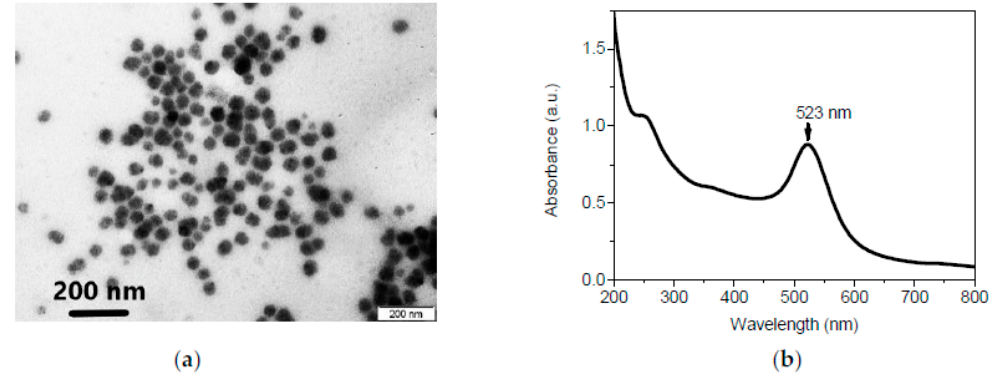
Figure 1. ( a ) TEM image of the PPy NPs; ( b ) UV-VIS analysis of the Au